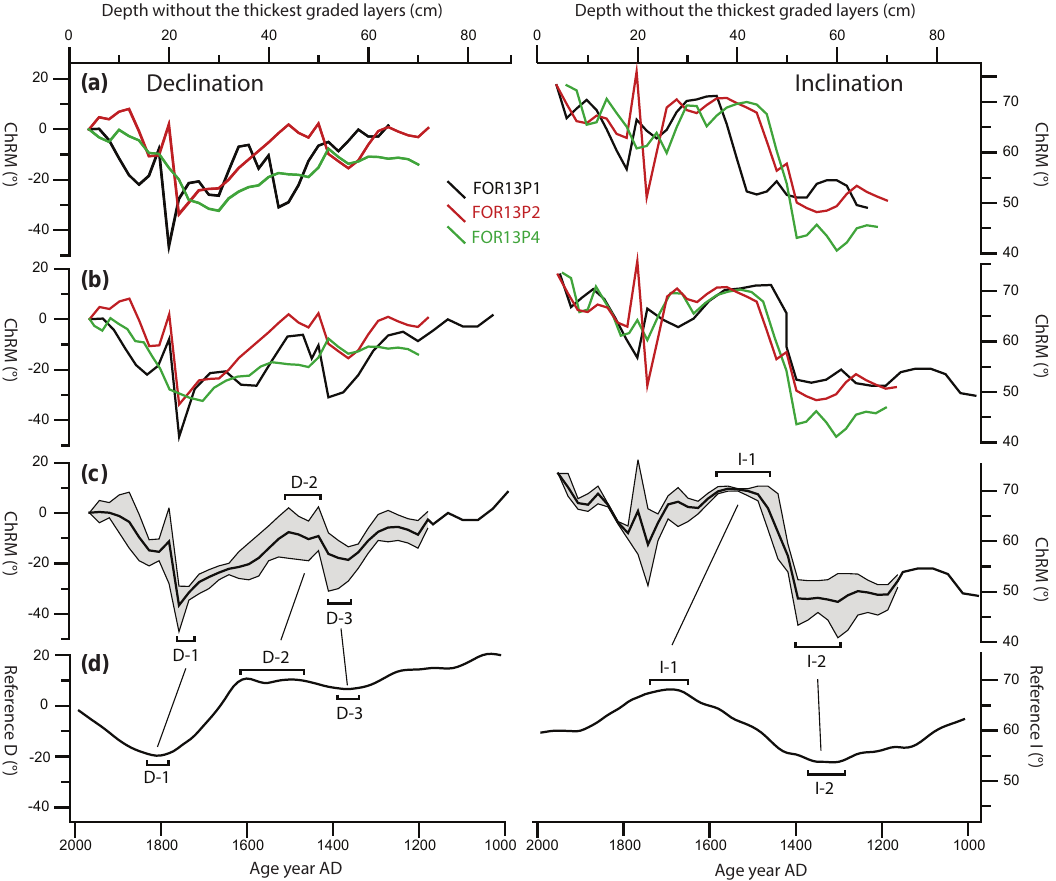
Figure 5. (a) Raw declination and inclination profiles of cores FOR13P1, FOR13P2 and FOR13P4. (b) The same profiles after removal of the thickest graded beds (interpreted as event layers) and adjustment of the different specific-core depths to a common reference depth. (c) Average of profiles shown in (b) . (d) Correlation to the ARCH3.4k model reference curve of declination and inclination (Donadini et al., 2009; Korte et al., 2009). ChRM means characteristic remanent magnetization. The well-correlated declination and inclination features are labelled D-x and I-x,